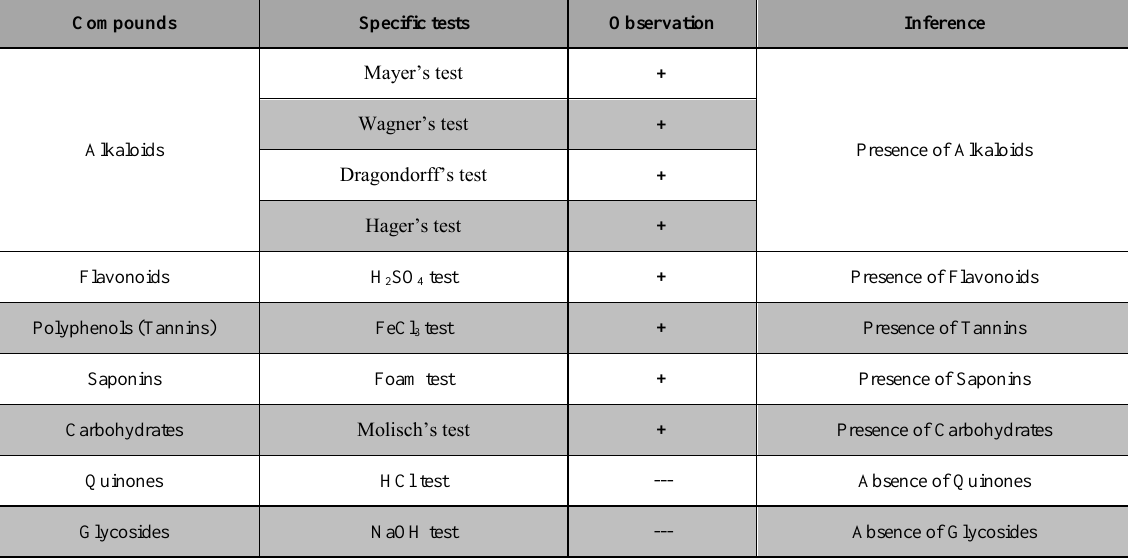
Table 5. Results of preliminary phytochemical analysis of endocarp of Cocos